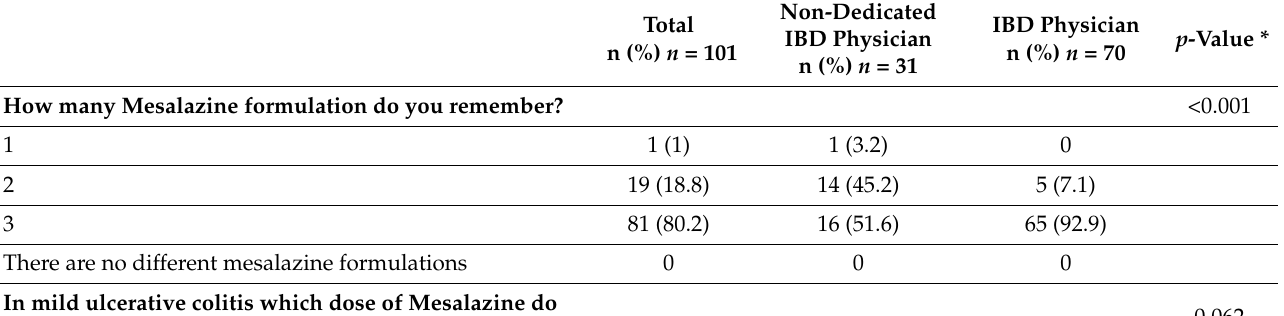
Table 2. Management of inflammatory bowel diseases with